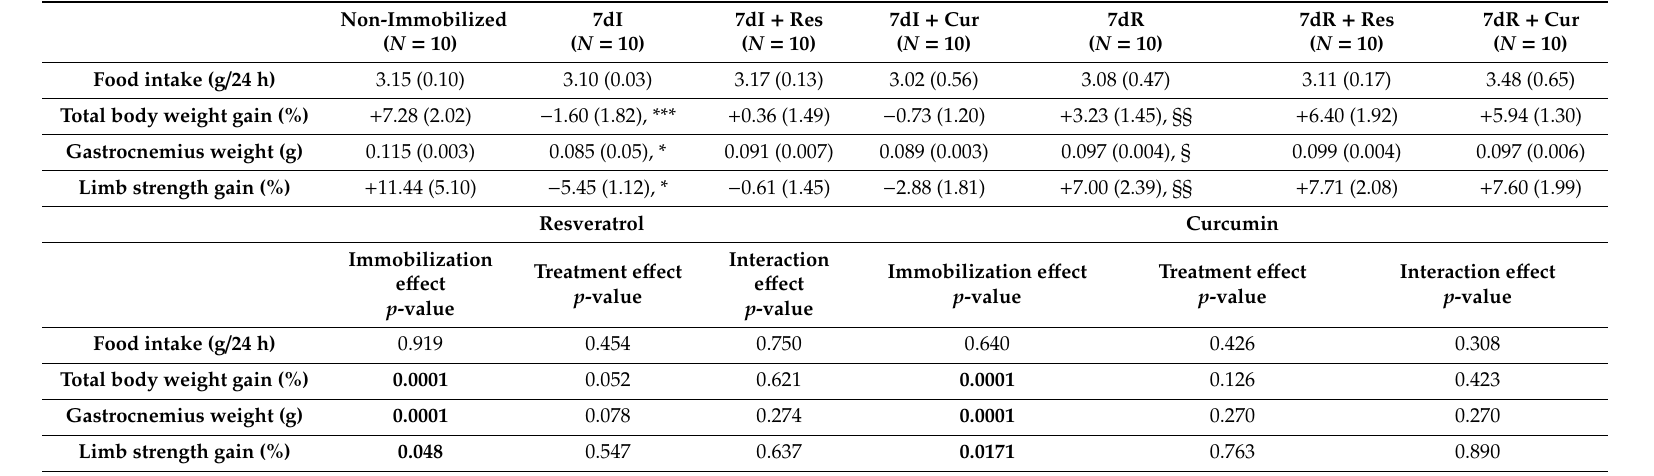
Table 1. Physiological parameters in all experimental groups of